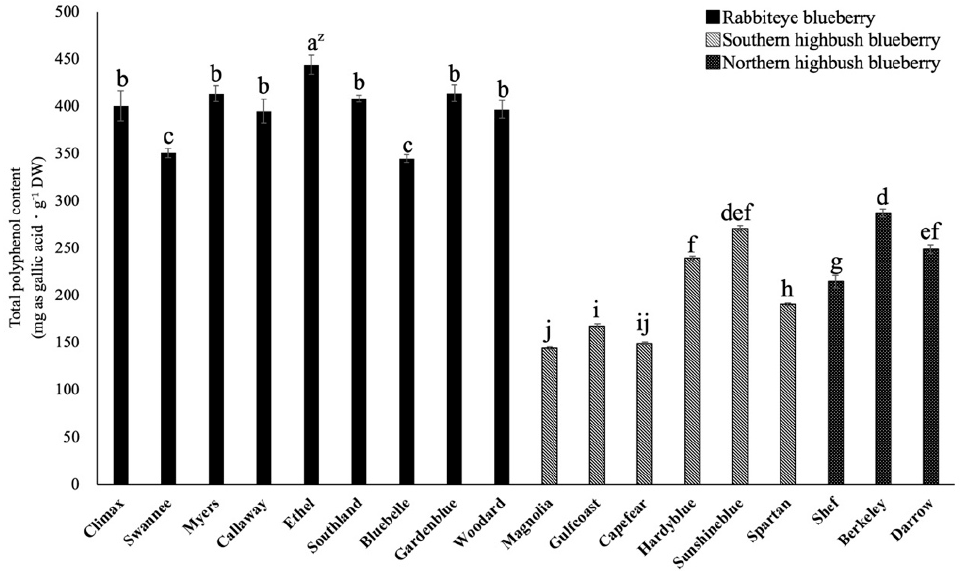
Figure 2. Comparison of the total polyphenol content in mature leaves of blueberry varieties. z Different letters among varieties represent significant differences at 5% level as determined by Tukey’s multiple range test (n = 3).